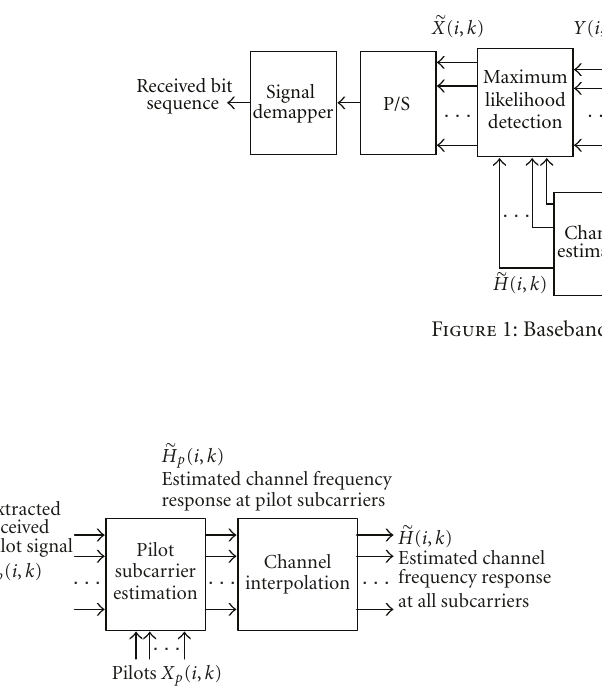
Figure 2: Channel estimation based on comb-type